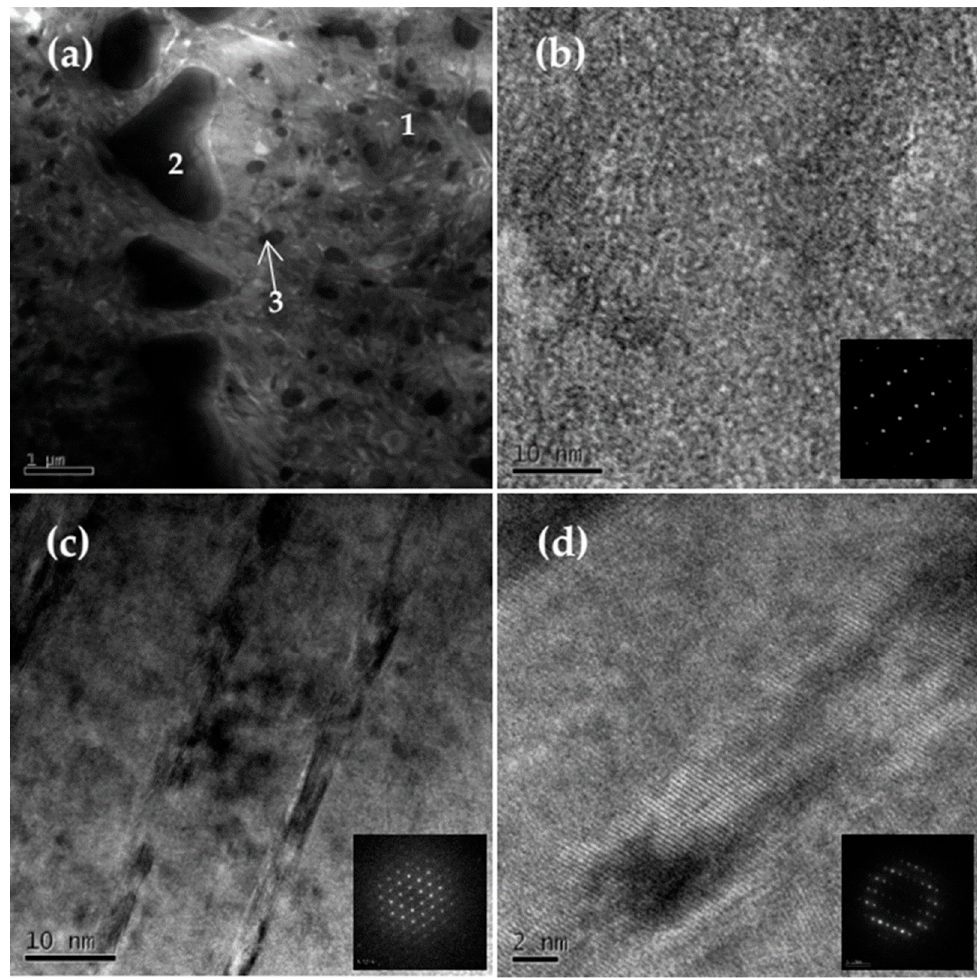
Figure 7. TEM characterization of microstructure in the HT sample ( a ) Bright field image; ( b ) HR-TEM image of matrix and inserted SADP pattern (at point 1) refer to martensite phase; ( c ) HR-TEM image and SADP (at point 2) refer to carbide M 7 C 3 ; and ( d ) HR-TEM image and SADP (at point 3) refer to M 23 C 6 .